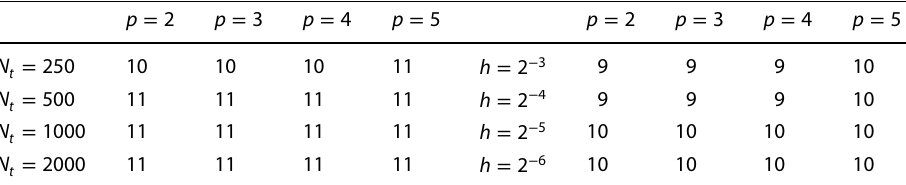
Table 3 Number of MGRIT iterations for solving Eq. (1) on the unit cube when adopting V-cycles for a varying number of time